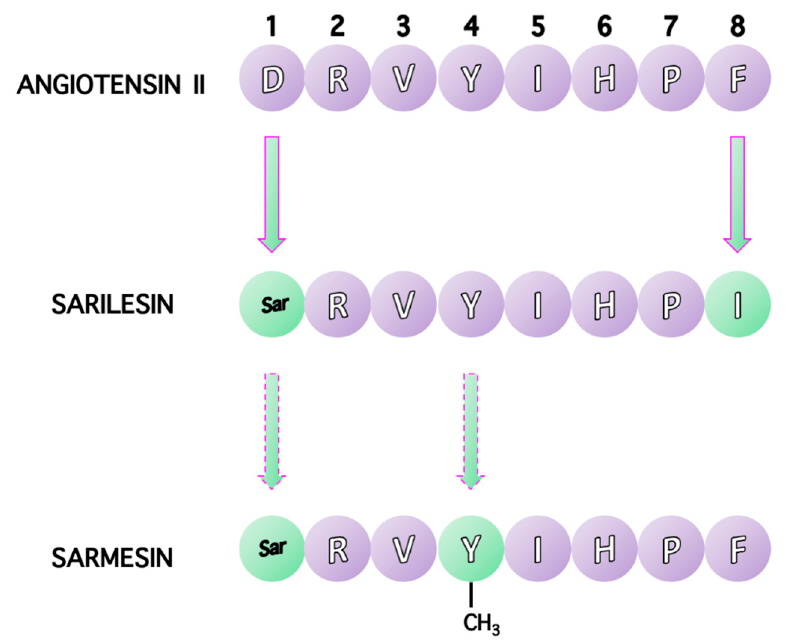
Figure 5. The peptide sequences of angiotensin II (Asp-Arg-Val-Tyr-Ile-His-Pro-Phe), sarilesin [Sar 1 , Ile 8 ] ANGII, and sarmesin [Sar 1 , Tyr (OMe) 4 ] ANGII. Phenylalanine at position 8 and tyrosine at position 4 are crucial for triggering hypertensive activity.